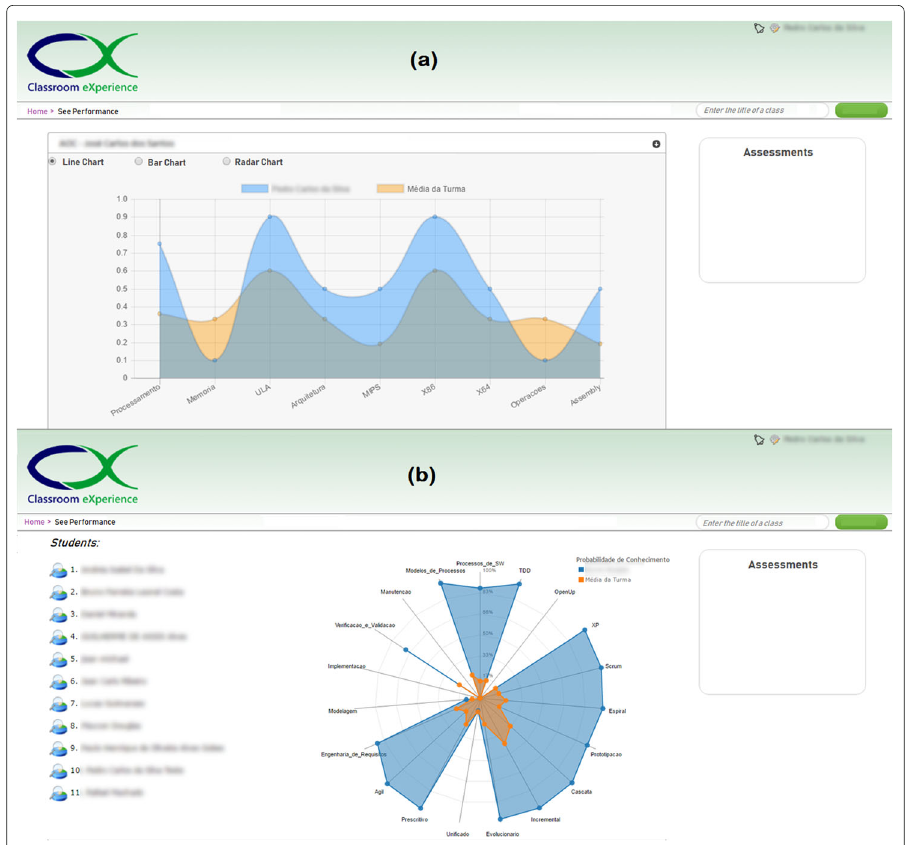
Fig. 4 Visualization interface. OSM-V integrated to Classroom eXperience, visualization interface available for (a) students and (b) instructors (source: (Ferreira et al.